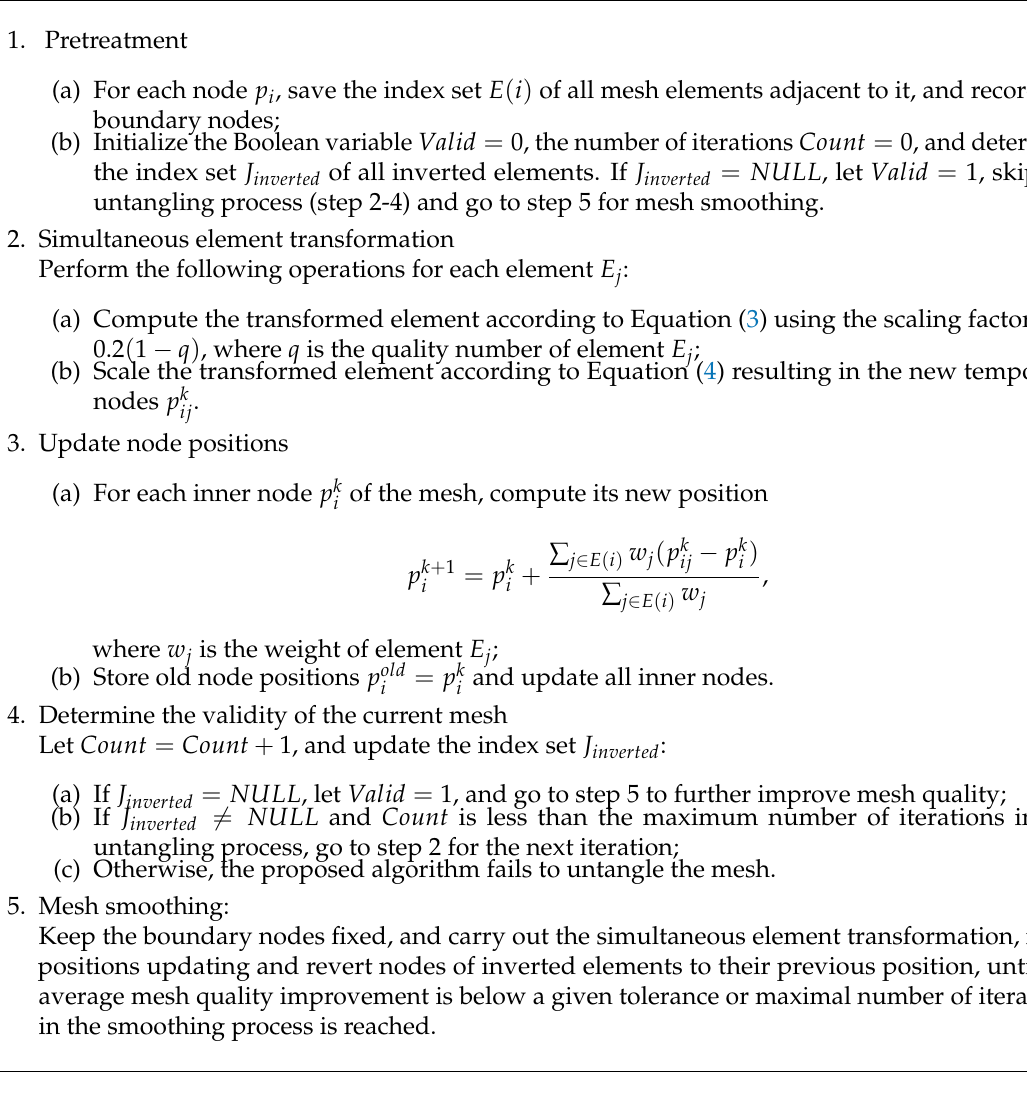
Algorithm 1 EEGT-based simultaneous untangling and smoothing of 2D